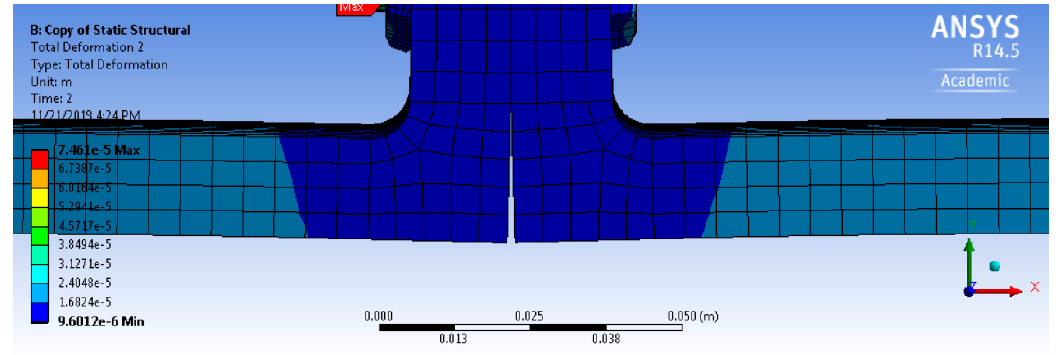
Figure 6. The flanges separation under